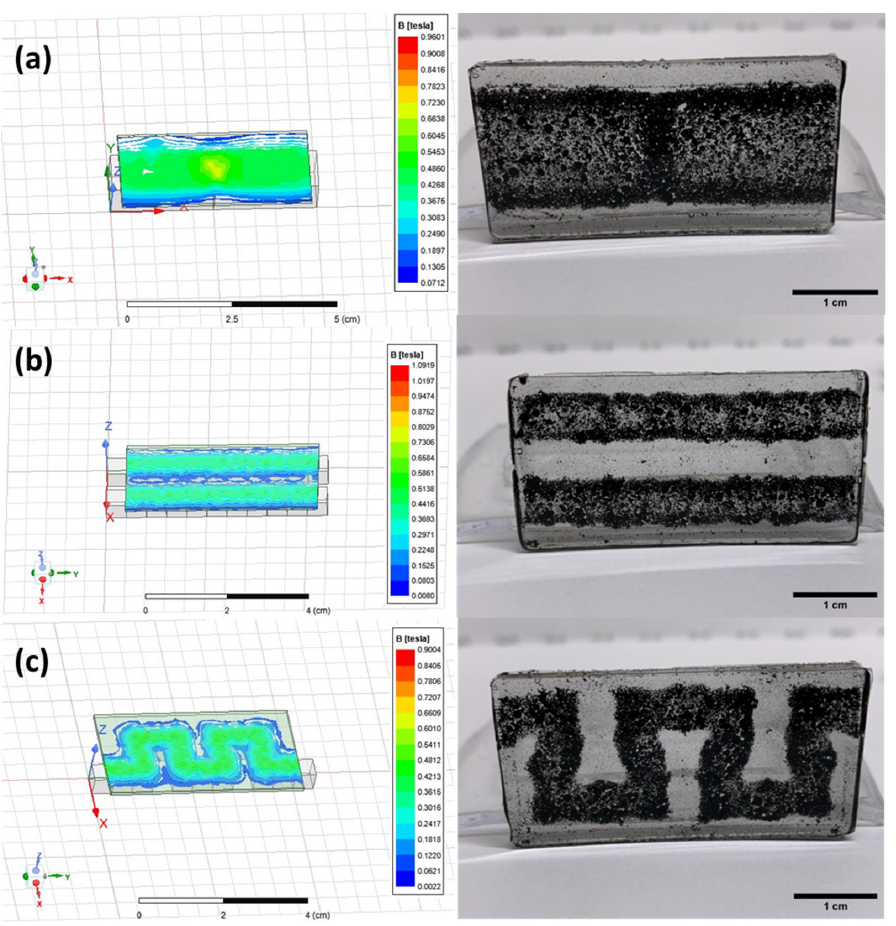
Figure 10. Magnetic patterns in Ansys Maxwell and magnetic patterns of MWCNT/PDMS achieved in the laboratory, ( a ) Rectangular; ( b ) Parallel lines; and ( c ) Zig zag shape.